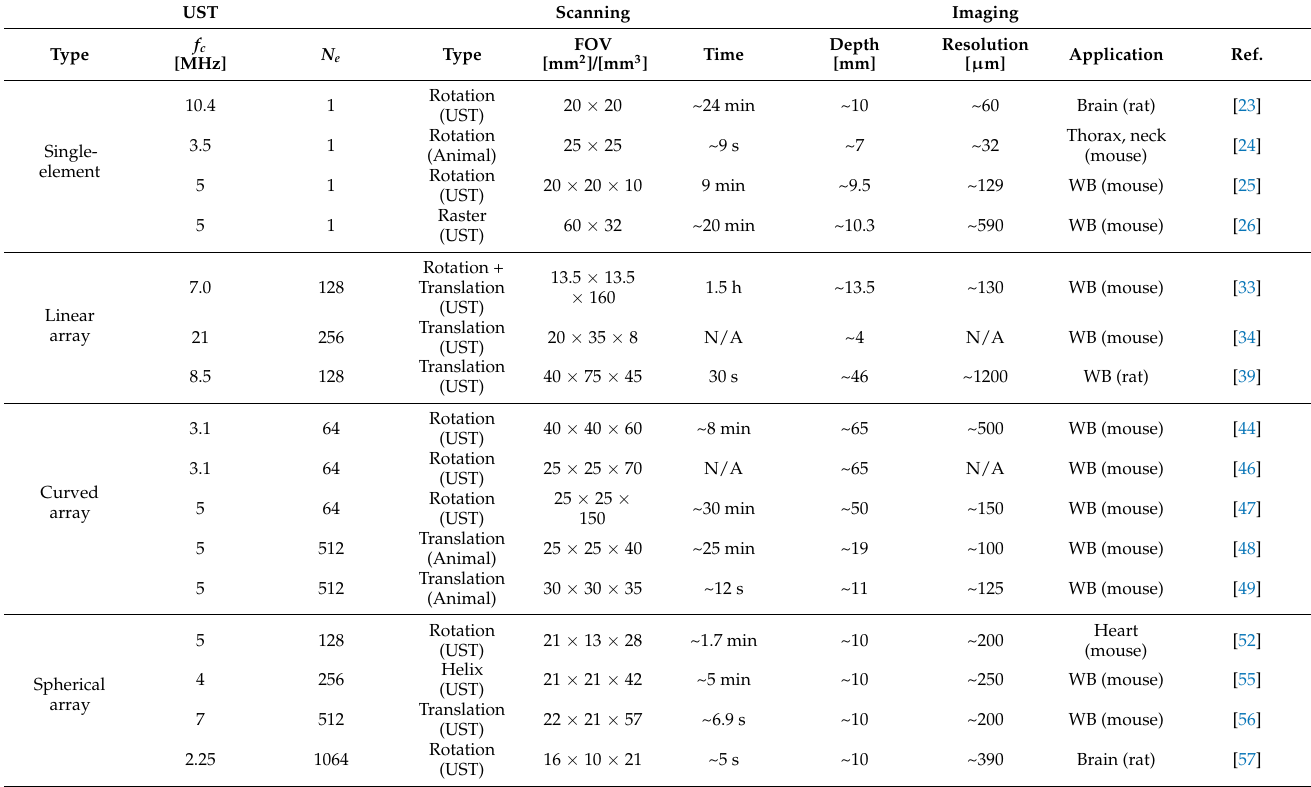
Table 1. The characteristics of USTs, scanning mechanisms, and resulting images in PAI systems. UST, ultrasound transducer; PAI, photoacoustic imaging; f c , center frequency; N e , number of elements; FOV, field of view; WB, whole-body. Scanning